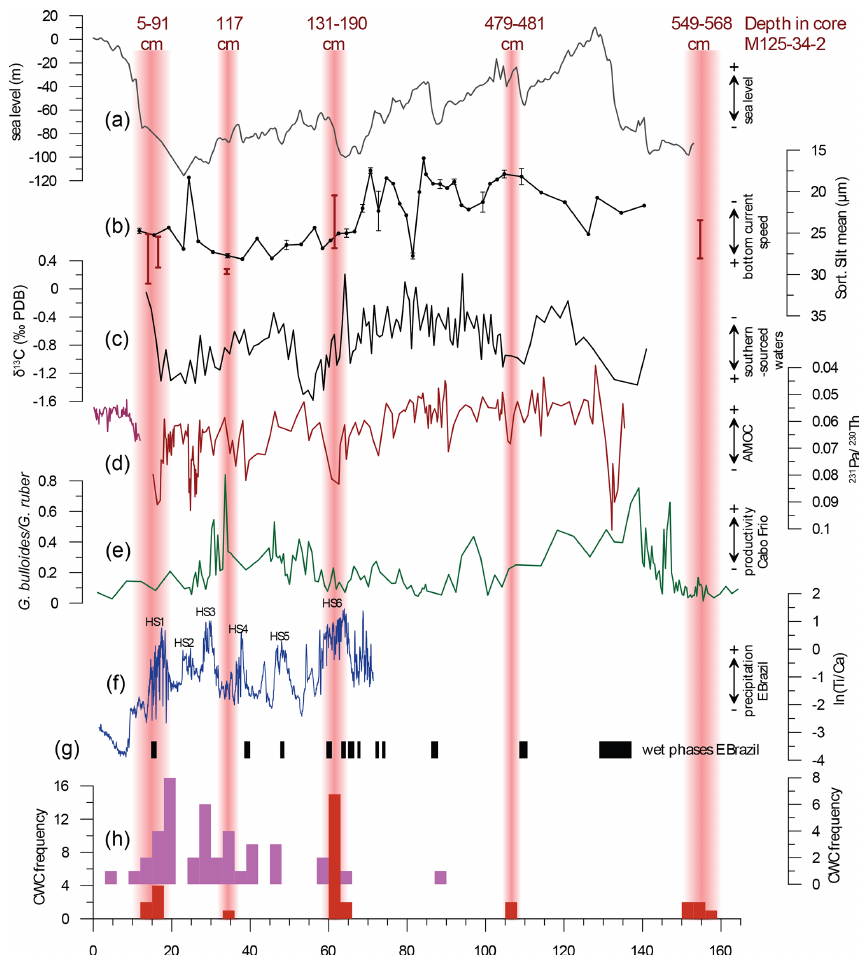
Figure 5. Frequency of CWC occurrences in the time domain at Bowie Mound core M125-34-2 and adjacent cores from the southeastern Brazilian margin in the paleoclimatic context. (a) Global sea level (Grant et al., 2012); (b) mean sortable silt in off-mound core M125-50-3 – range of sortable-silt values of CWC-bearing intervals in core M125-34-2 are indicated by red bars; (c) benthic δ 13 C of Uvigerina spp. in off-mound core M125-50-3, reflecting the portion of southern-sourced waters (AAIW) at the southeastern Brazilian margin; (d) variability of Atlantic Meridional Overturning Circulation (AMOC; dark red line: Böhm et al., 2015; purple: Lippold et al., 2019); (e) upwelling intensity at Cabo Frio, reflected by the ratio between upwelling-related planktonic foraminifer Globigerinoides bulloides and oligotrophic Globigerinoides ruber ; (f) ln(Ti / Ca) ratio, reflecting terrigenous input to the eastern Brazilian margin off the São Francisco River (core M125-95-3; Campos et al., 2019); (g) growth periods of travertine and speleothems in eastern Brazil during anomalous wet periods, indicated by black bars (Wang et al., 2004); (h) frequency of CWC Th / U dates per 3kyr bins at Bowie Mound (core M125-34-2; red bars) and in cores at the southeastern Brazilian margin (violet; Mangini et al., 2010; Ruckelshausen, 2013; Fig. 1). Note the good match between CWC occurrences and enhanced monsoonal activity on the continent (correlation between ln(Ti / Ca) and CWC frequency: r = 0 . 56, p = 0 . 02; computed using the SurrogateCor function of the R package “astrochron”; Meyers, 2014). Red bars indicate periods of enhanced CWC growth at Bowie Mound, with the respective depths in core M125-34-2